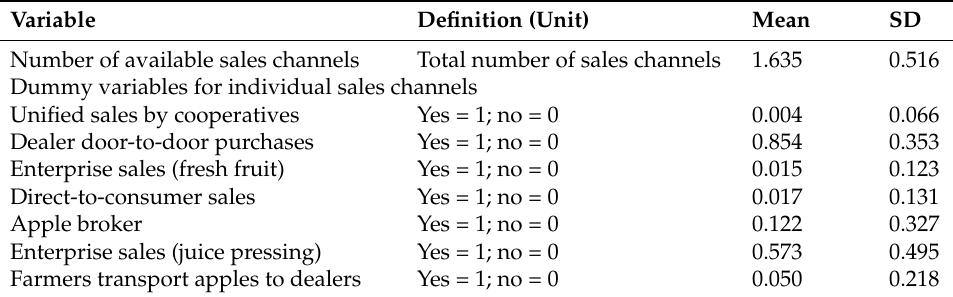
Table 2. Sales channels: definitions and summary statistics.